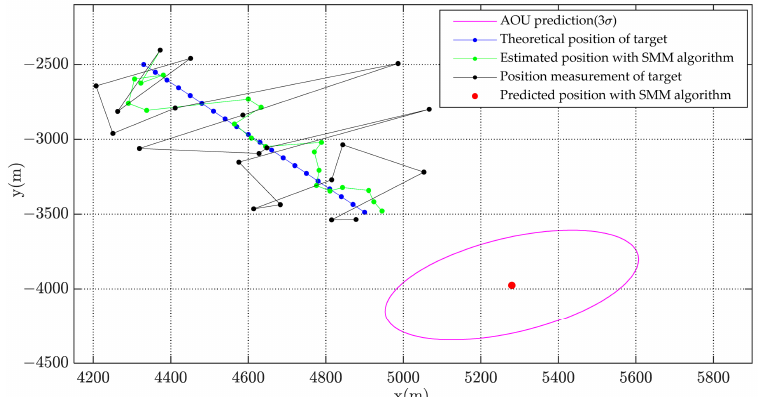
Figure 11. Underwater target tracking and its AOU.